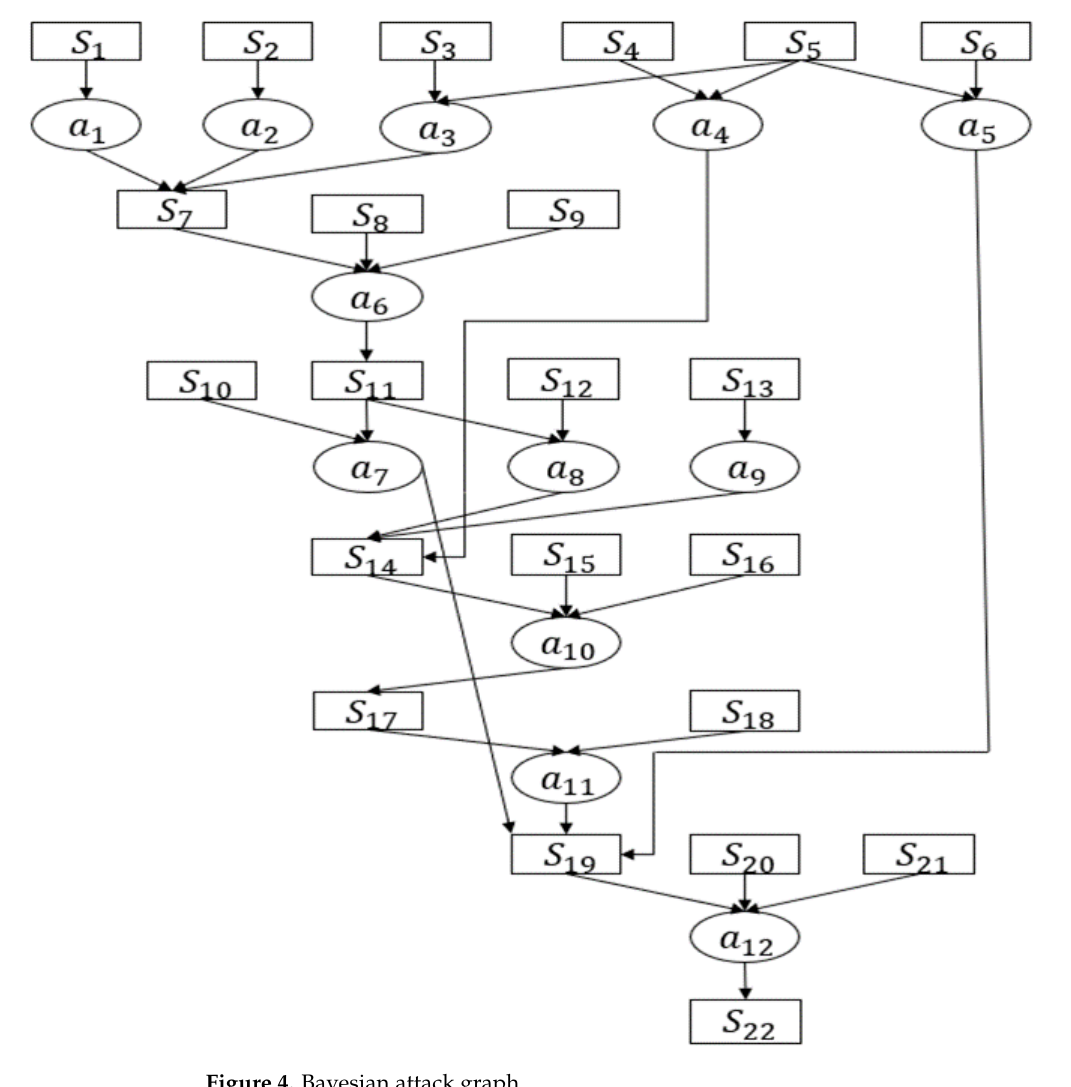
Figure 4. Bayesian attack